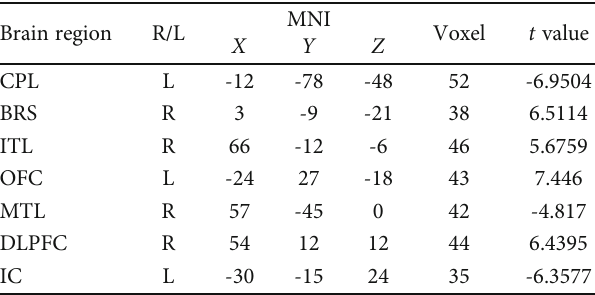
Figure 9: Regions showing signi fi cantly di ff erent EC with the rACC in nocebo status compared with pain status Table 6: Locations of the regions showing signi fi cantly altered EC with the rACC in nocebo status compared with pain status in EG ( p < 0 : 05 , FDR < 0 : 05 ).